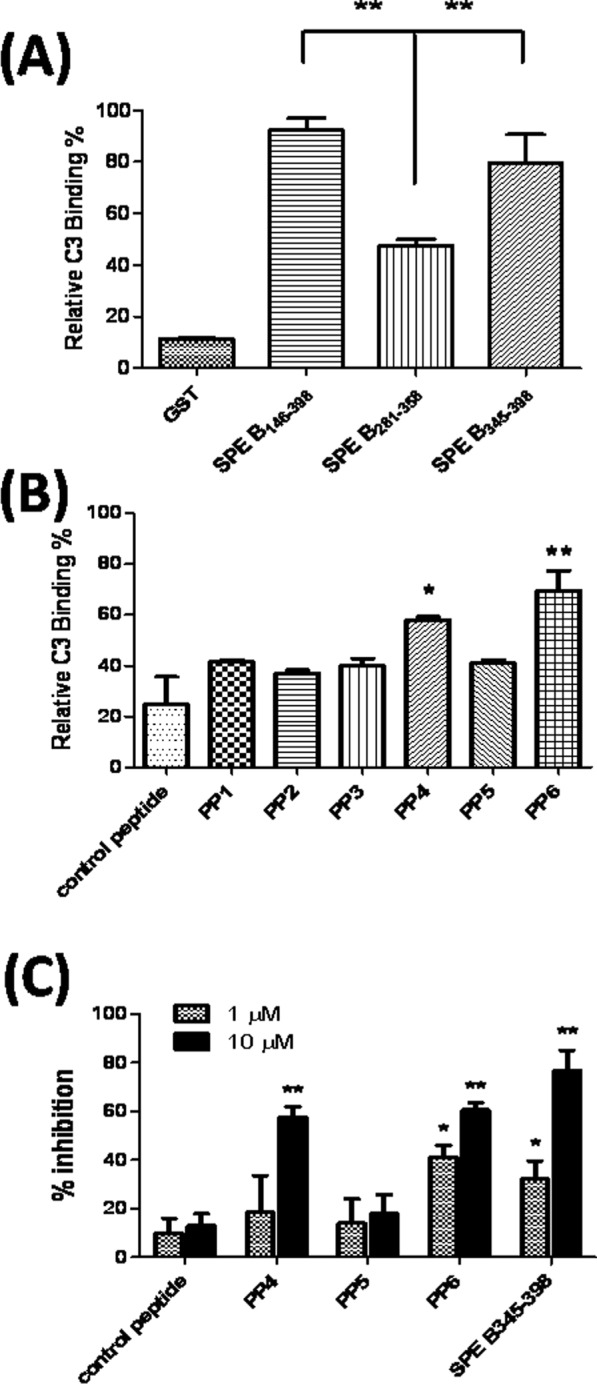
Serum C3 bound the C-terminal domain of SPE B.(A) Either equal moles of the purified recombinant SPE B mutant proteins, control GST or (B) the synthetic peptides PP1-PP6, containing the C-terminal region from residues 301 to 398, was used to coat a 96-well ELISA plate. The binding efficiency of the SPE B truncated mutants or synthetic peptides to serum C3 was detected by ELISA. (C) Different concentrations of synthetic peptides or SPE B345–398 were incubated with human serum and then added to the C192C-coated plates. The inhibiting ability of the synthetic peptides or SPE B345–398 was expressed as the ratio of C3-binding to the C192S with pretreatment of synthetic peptides or SPE B345–398 to the binding of C3 to C192S without pretreatment of synthetic peptides or SPE B345–398, as described in the Materials and Methods. The synthetic peptide PP4 and PP6 showed > 50% inhibitory activity on C3 and SPE B interaction. **P< 0.01, compared with values determined for the SPE B281–358 (A), *P< 0.05, **P< 0.01, compared with values determined for the control peptide (B, C).